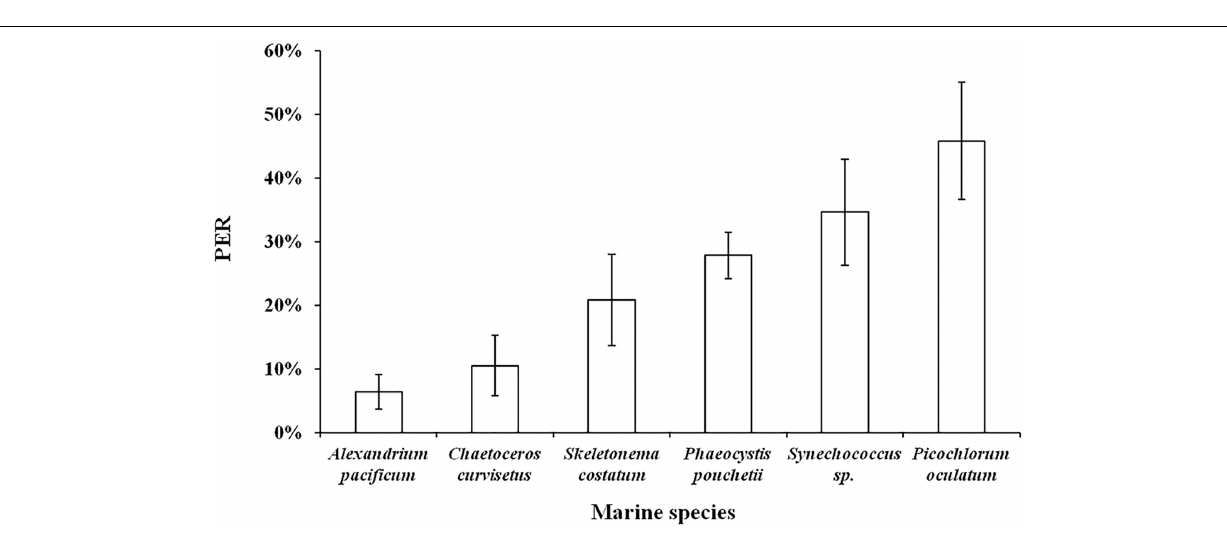
FIGURE 9 | Relationship between phytoplankton with different particle sizes and PER in simulated culture